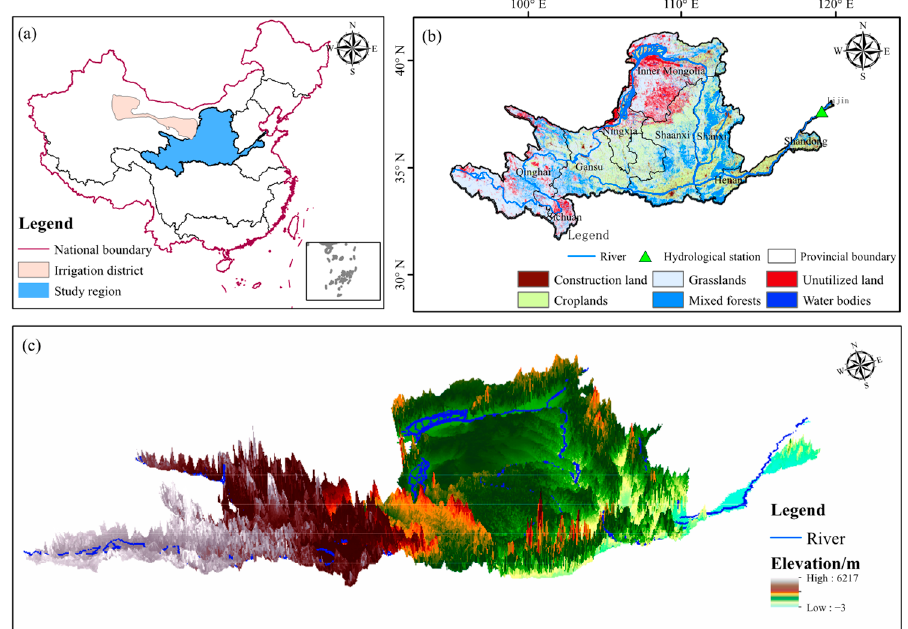
Figure 1. Location ( a ), LULC types ( b ), and terrain ( c ) of the YRB.